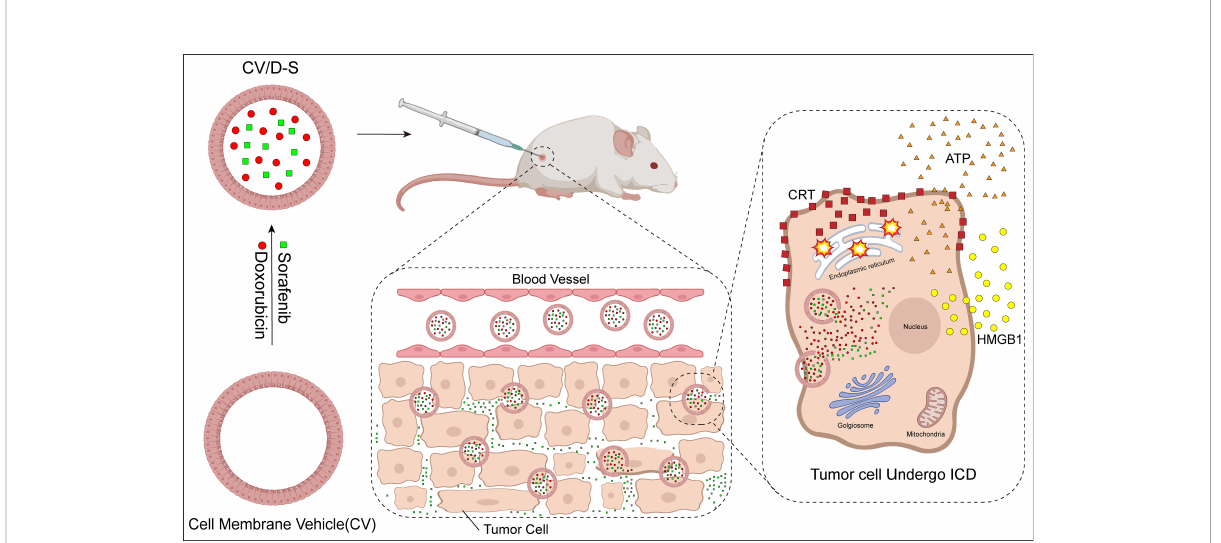
FIGURE 4 Mechanism of action of cell membrane vehicle induced immunogenic cell death (ICD) response. Doxorubicin (DOX) and sorafenib (SFN) were encapsulated in a cell membrane vehicle to form a highly stable spherical particle CV/D-S. After injecting CV/D-S into experimental animals, the particle fl owed along the blood vessels to the location of tumor tissues and accumulated in large quantities at the site of tumorigenesis. The particle released SFN to regulate the TME. DOX induced ICD in tumor cells after